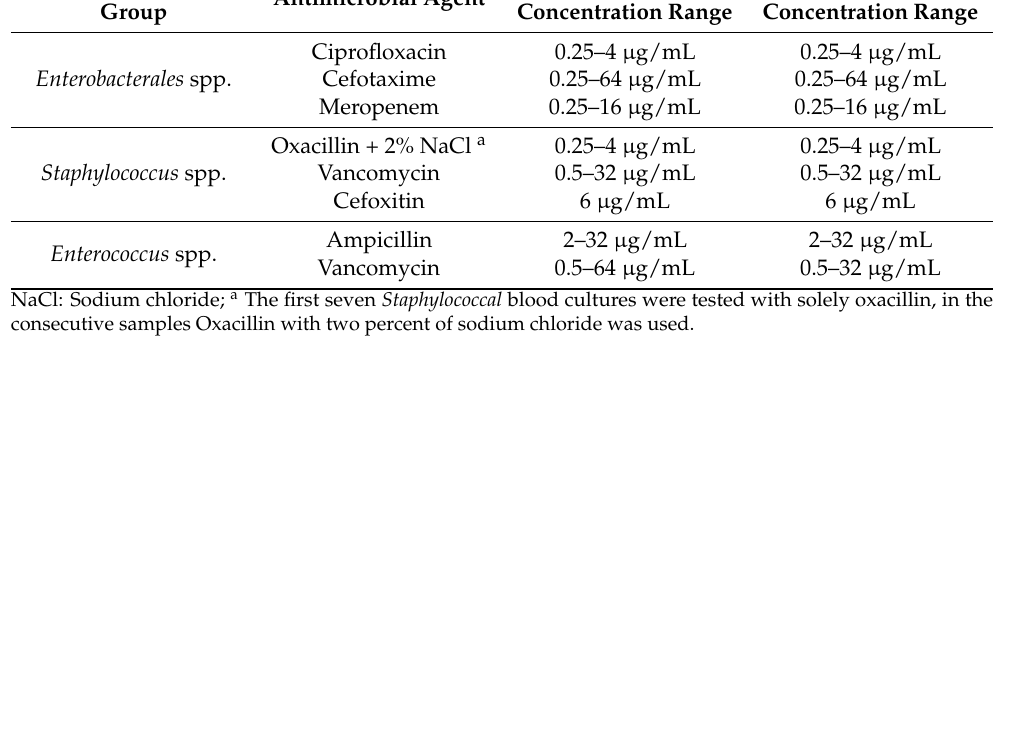
Table 1. Combinations of micro-organisms and antimicrobial agents (bug–drug combinations) and corresponding antibiotic concentration ranges tested.